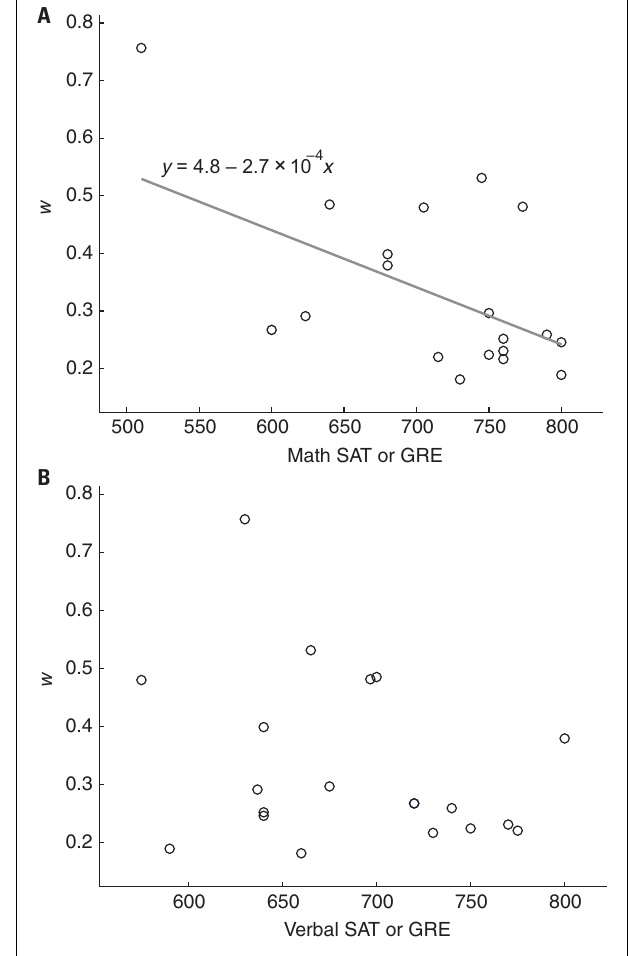
FIGURE 6 | (A) Numerosity w scores were positively correlated with line length w scores on session 1 ( r 2 = 0.44, p < 0.005) and session 6 ( r 2 = 0.38, p < 0.005, data not shown). Gray line is the best fit to the data and the equation shows the intercept and slope. (B) Change from session 1 to session 6 in numerosity w scores plotted against the change in line length w scores over the same period. Numerosity w scores were not